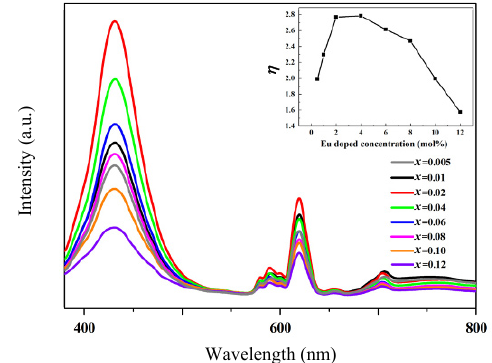
Fig. 6 PL spectra and dependence of η on the amount of Eu in Ba 0.79 Al 10.9 O 17.14 : x Eu ( x = 0.005–0.12) prepared at 1550 ℃ for 4 h.